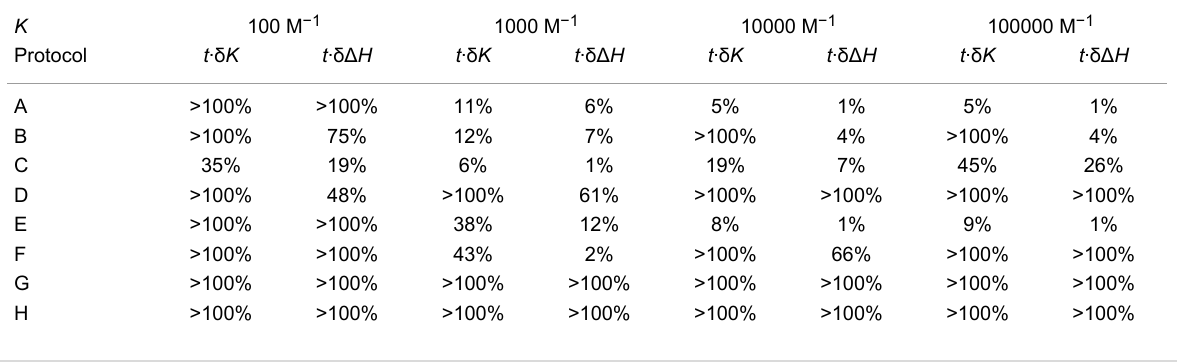
Table 1: Theoretical uncertainties of K and Δ H for the eight non-competitive ITC protocols with a guest solubility equal to 2